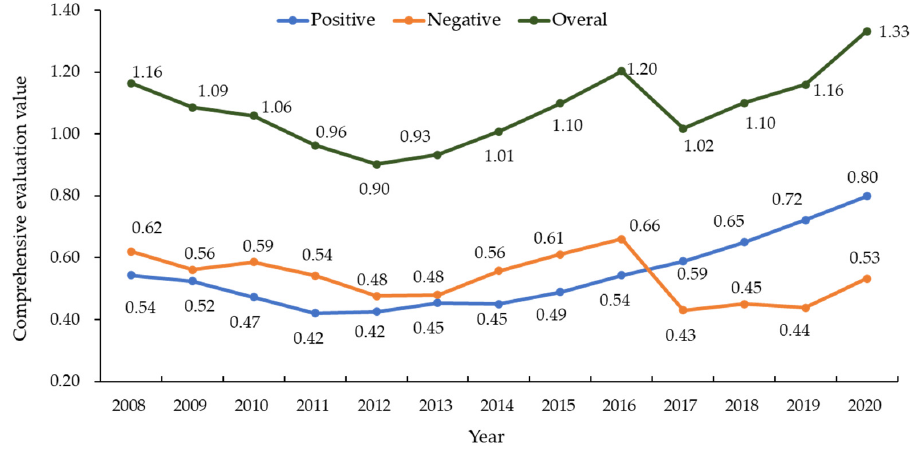
Figure 2. Trends of externalities of highway infrastructures in Jiangsu province in the past 13 years.